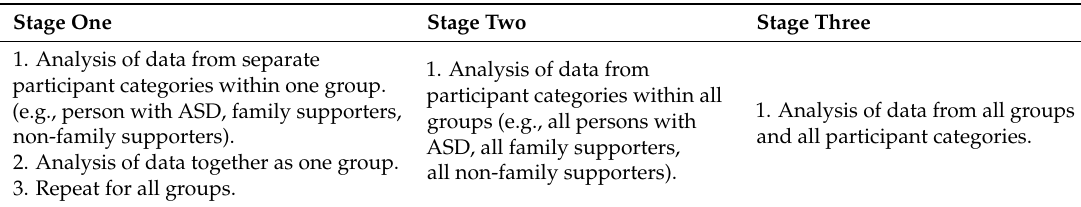
Table 3. Stages of